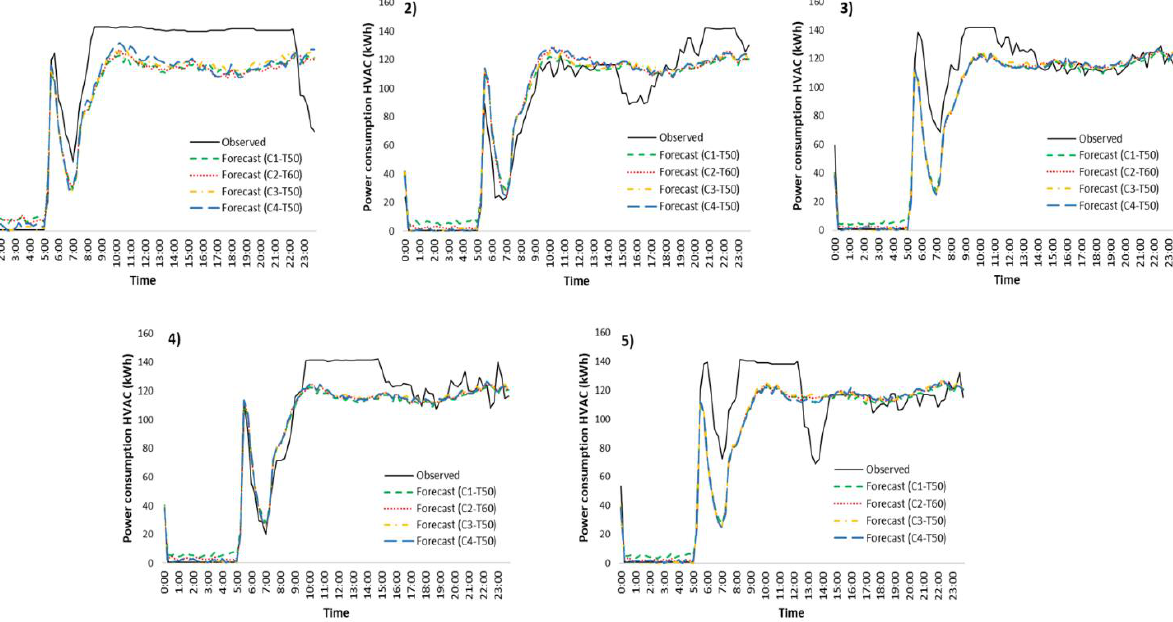
Table 8. Calculation of the relative error of the daily energy consumption (average and maximum) with respect to the testing-set (model: C1-T50). Forecast